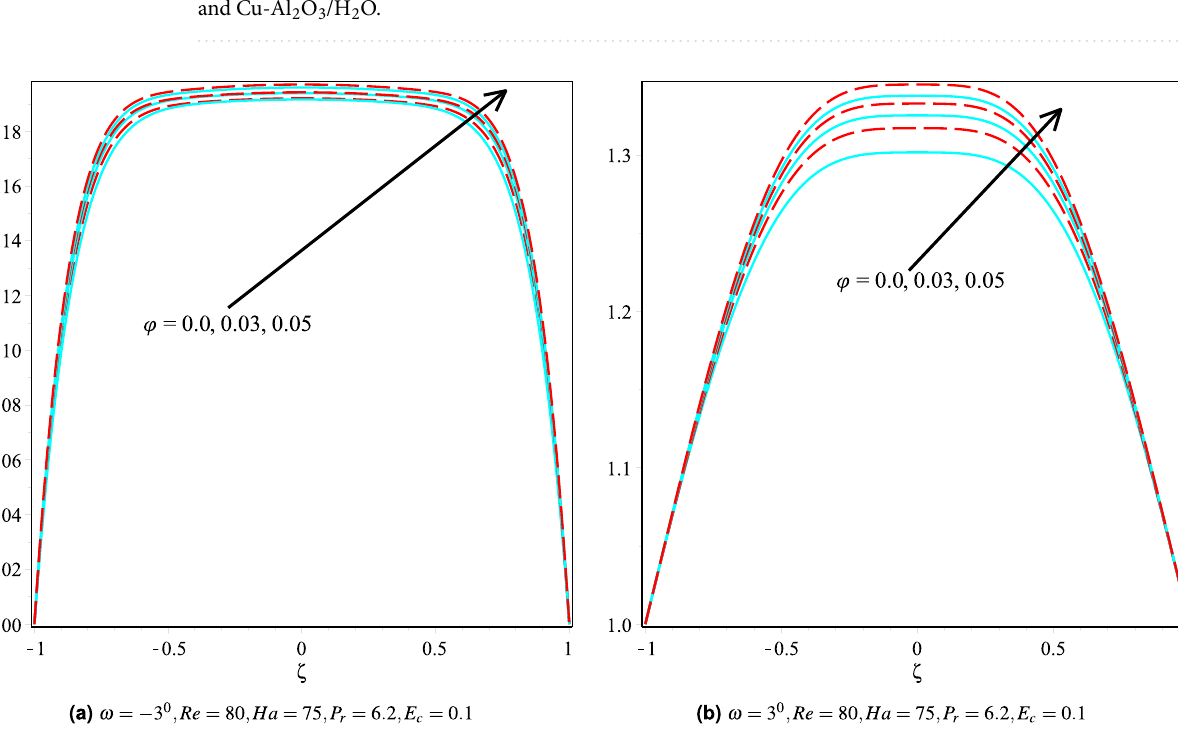
Figure 8. The heat boundary layers distribution in converging and diverging channel with various φ for Cu/ H 2 O and Cu-Al 2 O 3 /H 2